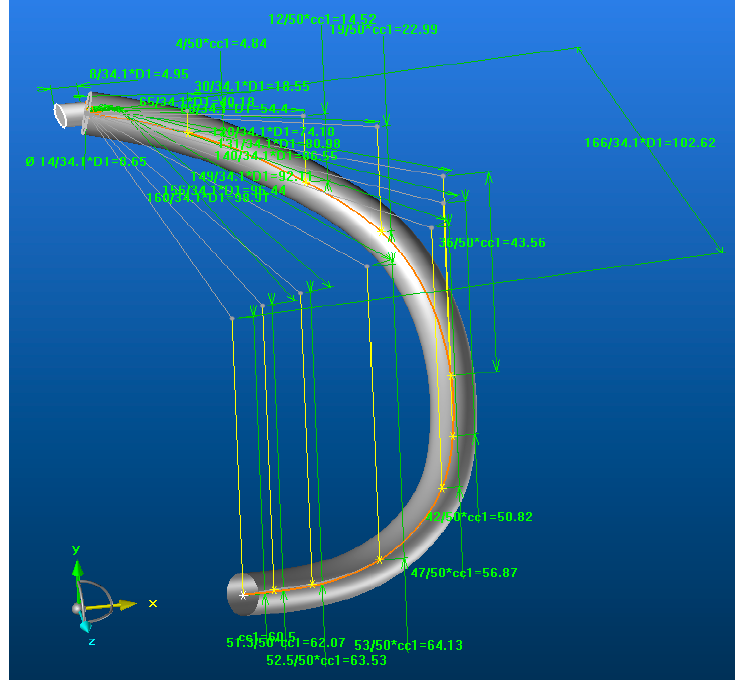
Figure 6. The adaptive models of the rib .